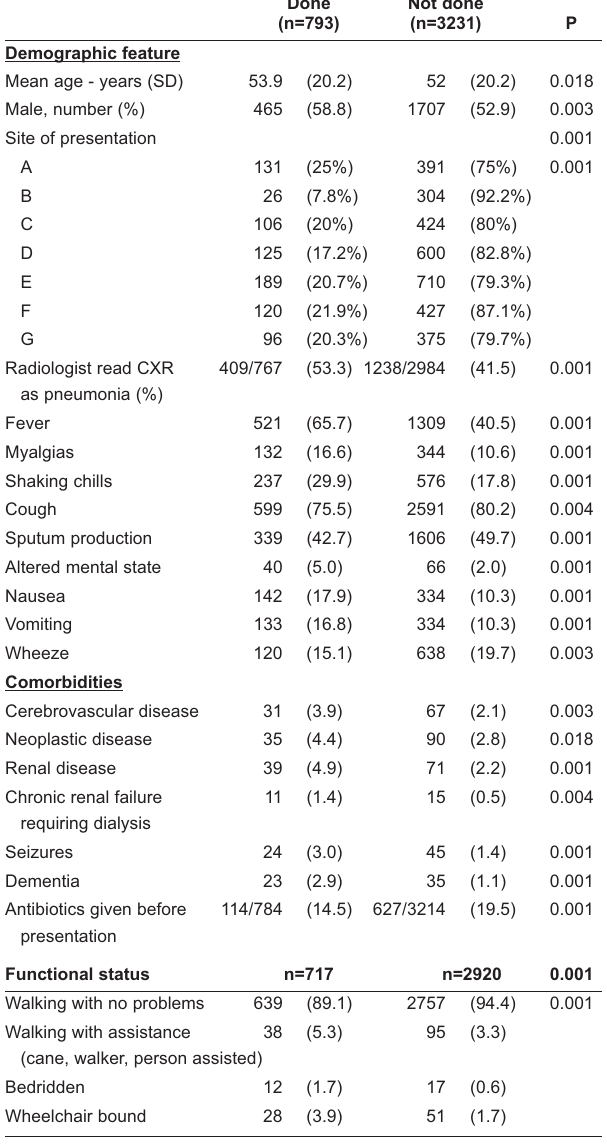
TABLE 1 Comparison of demographic features, symptoms and comorbidities for ambulatory patients with community- acquired pneumonia who had blood cultures done versus those who did not have blood cultures